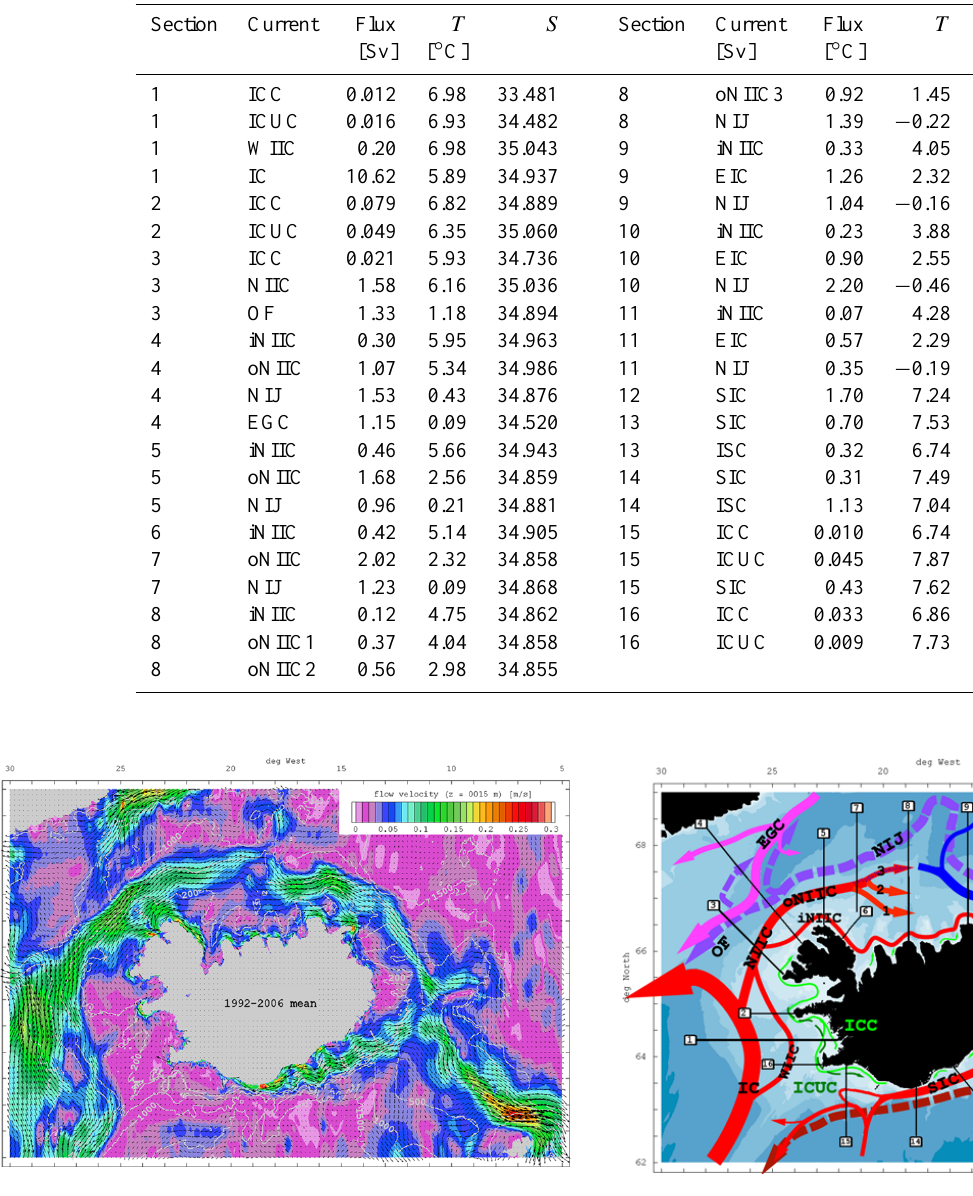
Fig. 7. Proposed three-dimensional circulation scheme of Icelandic waters with the locations of the 16 analysis sections. Dashed arrows denote deep currents. The abbreviations are: EGC – East